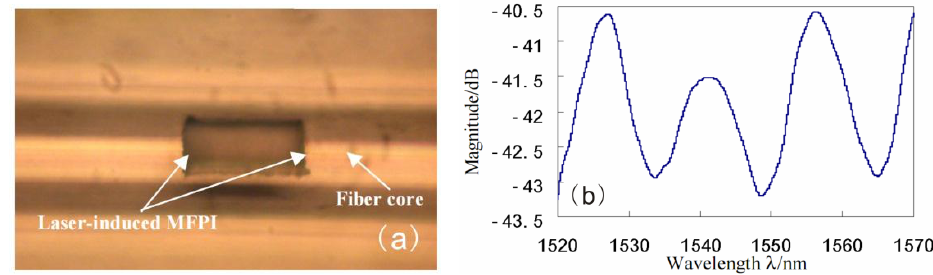
Figure 3. The MFPI with 80 μm cavity length based on the SMF: ( a ) microscope photograph of the cavity; ( b ) reflection